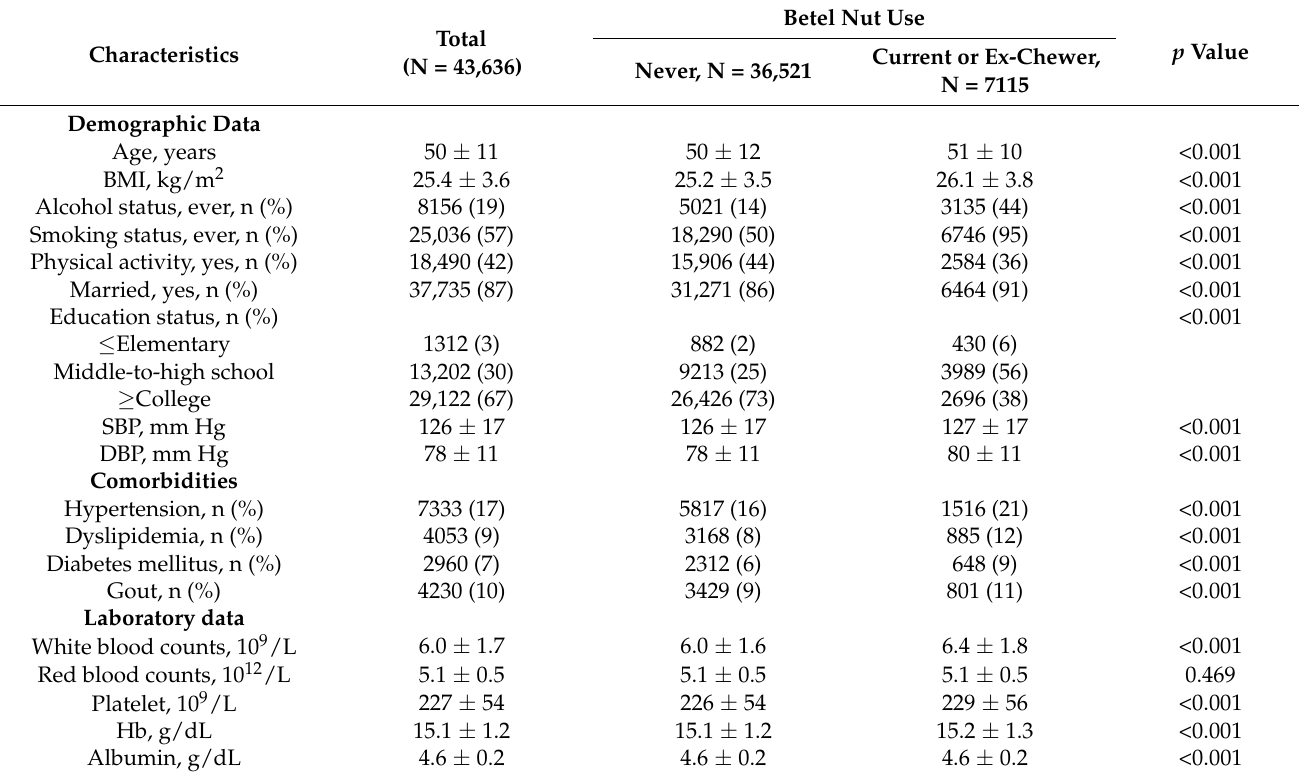
Table 1. Clinical characteristics of the study participants classified by betel nut